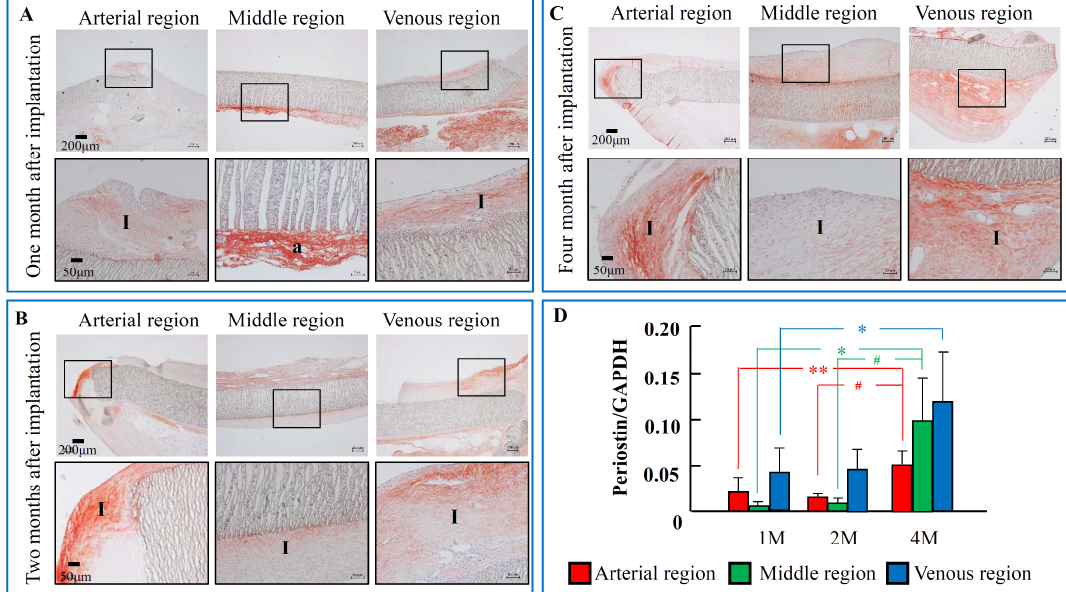
Figure 2. Immunostaining pattern and mRNA expression level of periostin during the 4-month post-PTFE graft implantation period. ( A – C ) Representative periostin immunostaining at the different regions of PTFE grafts 1, 2, and 4 months after PTFE graft implantation. The black frame of bottom pictures (A, B, C) are the extended image of the black boxes in the upper pictures. ( D ) Time-dependent changes of periostin mRNA expression levels 1, 2, and 4 months after PTFE graft implantation. I: intima side; a: adventitial side. Each bar represents the mean ± S.E.M. of six grafts. * p < 0.05, ** p < 0.01 vs 1 M; # p < 0.05 vs 2 M.